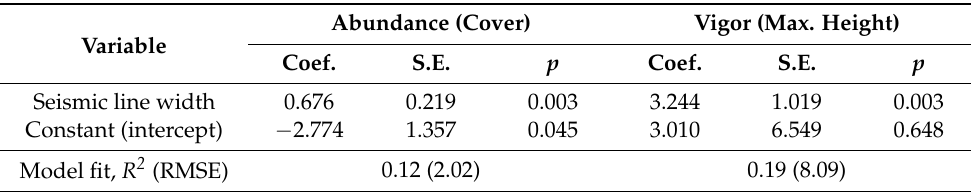
Table 4. Linear regression results relating forest gap (seismic line) width to abundance and vigor of Vaccinium myrtilloides .